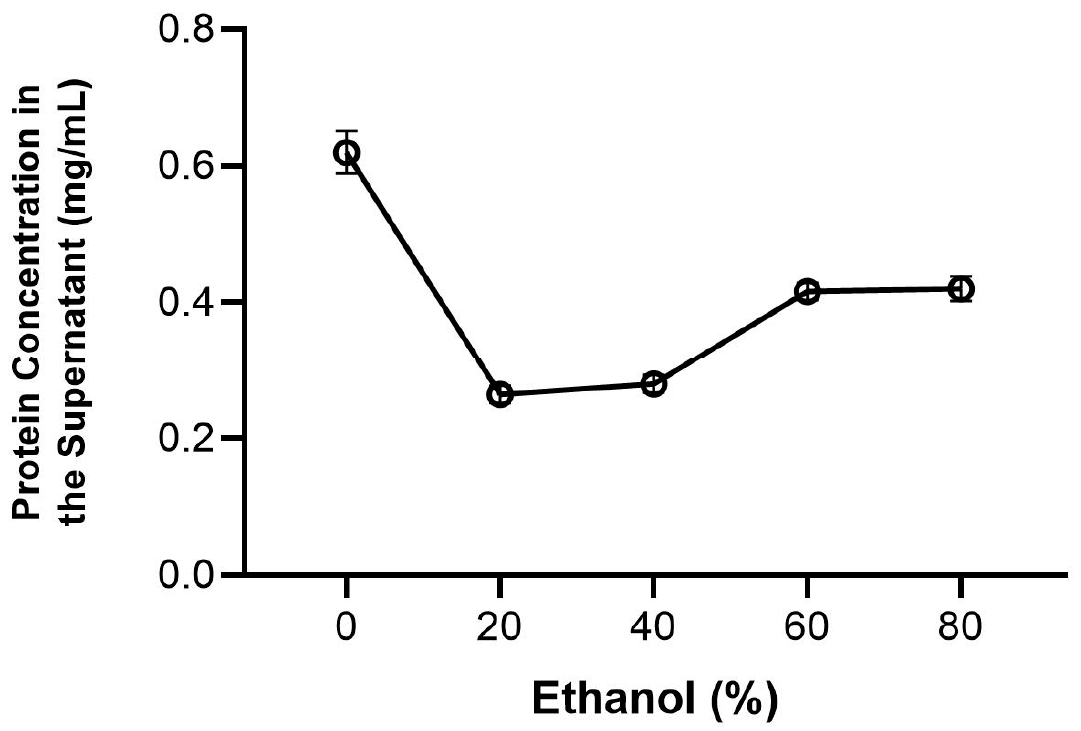
Figure 2. Effect of the ethanol concentration on protein transference from the powder to the super- natant.